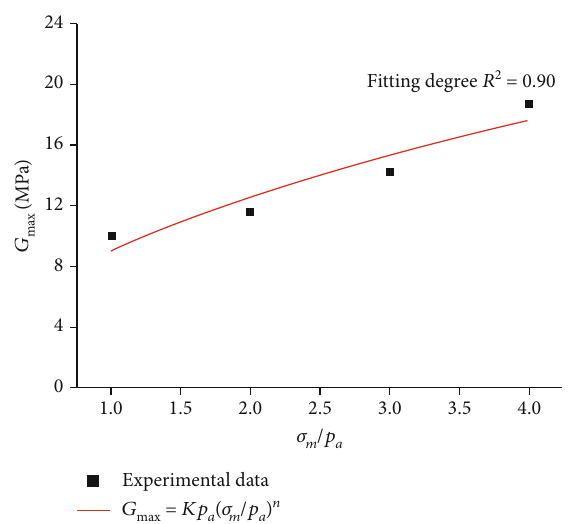
Figure 8: Calcareous calcareous sand G